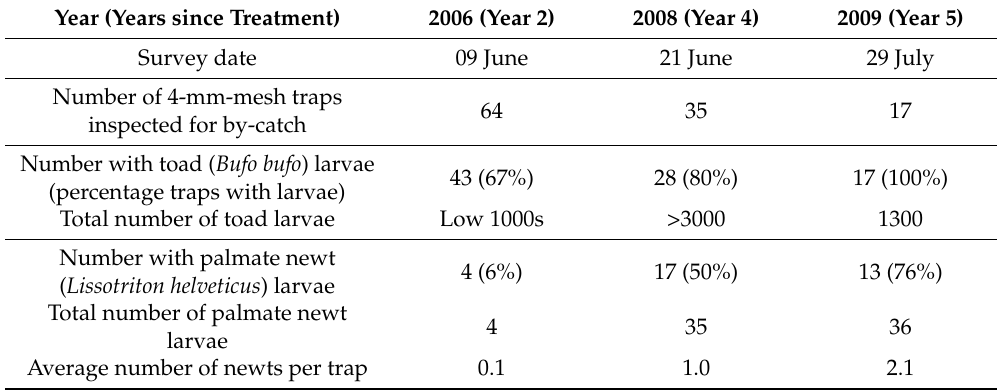
Table 7. The recorded bycatch of amphibian larvae in fine-mesh (4 mm) crayfish traps in years following biocide treatment at the gravel pit (U.K. site